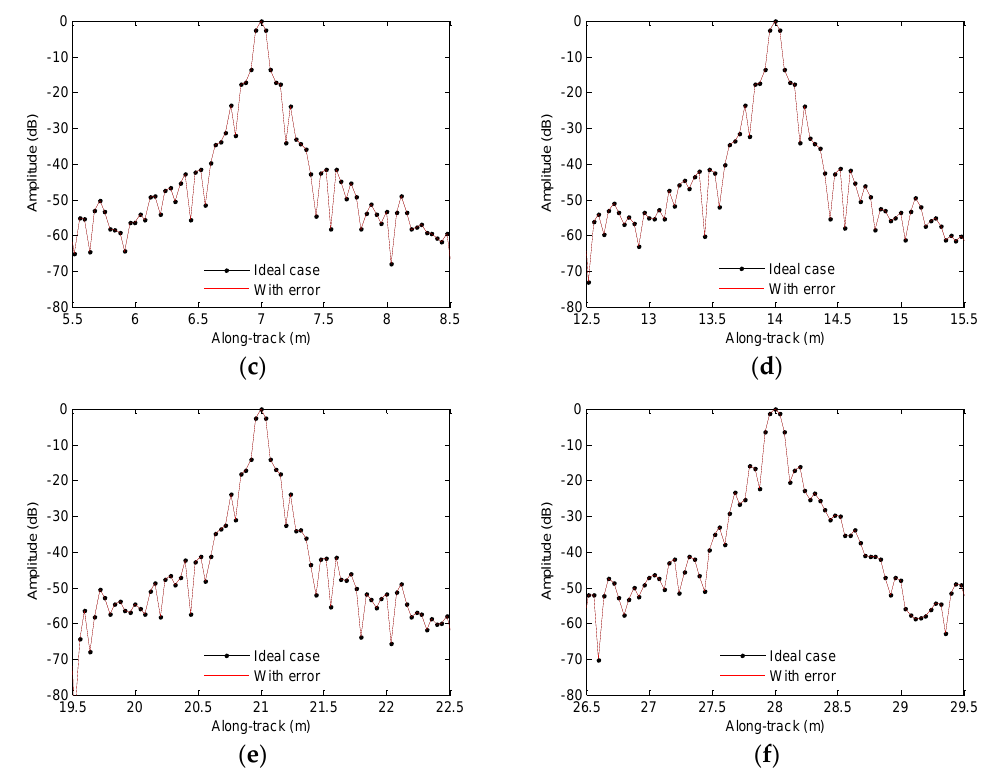
Figure 10. Processing results with the yaw perturbation: ( a ) imaging result; ( b ) slice of T1; ( c ) slice of T2; ( d ) slice of T3; ( e ) slice of T4; ( f ) slice of T5.